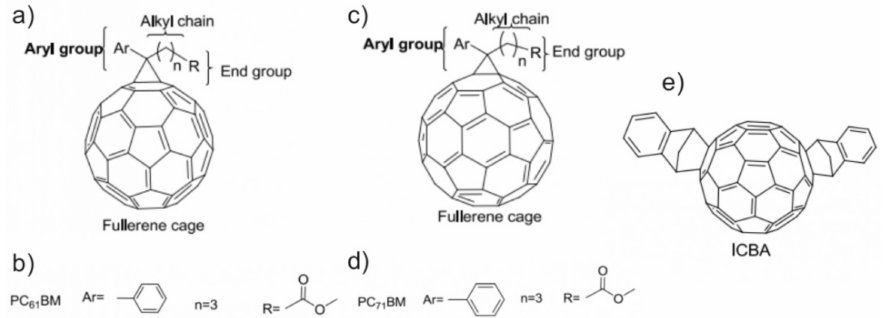
Figure 7. ( a , c ) Fullerenes C 60 and C 70 and their marked parts, which can be modified; ( b , d ) the fullerene derivatives PC61BM and PC71BM (see ( a , c ) for Ar, n, and R); ( e ) indene-based C60 bis- adduct [131]. Reprinted with permission of Elsevier (Copyright